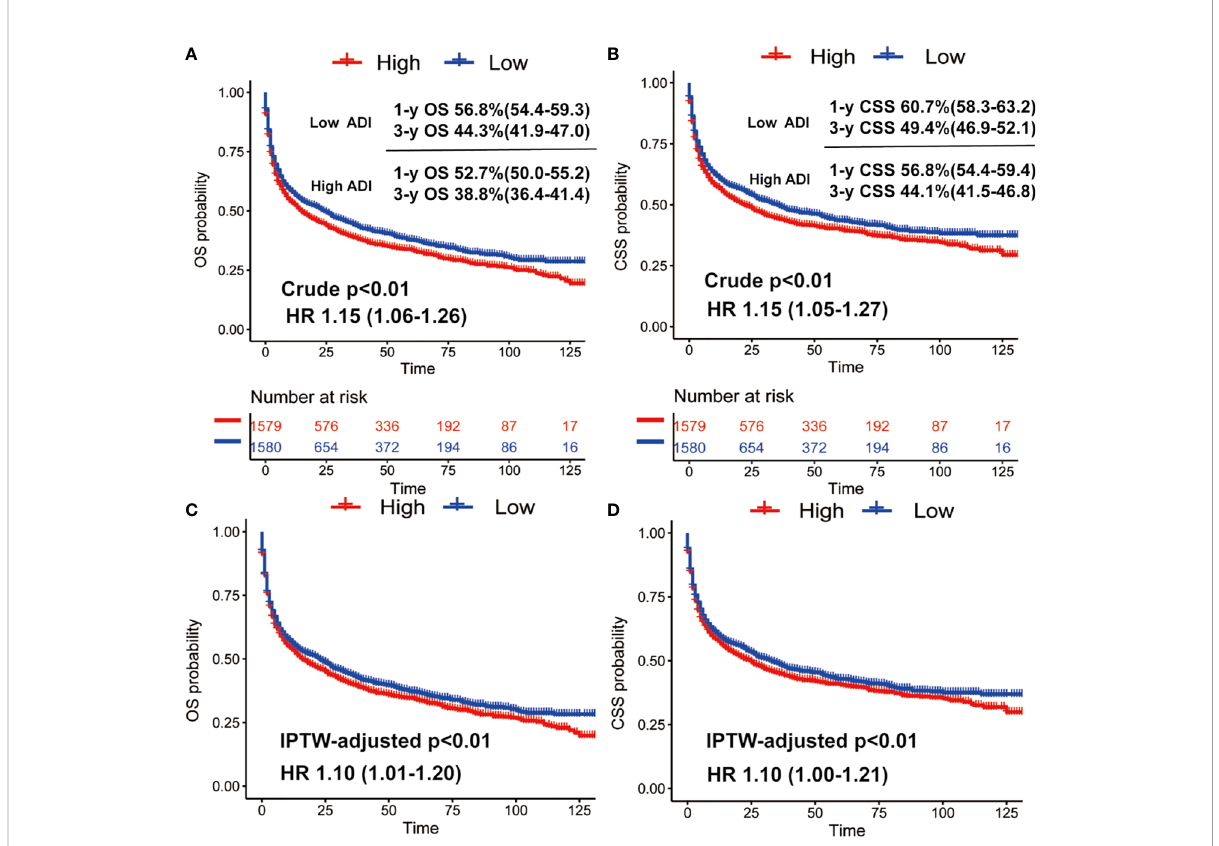
FIGURE 1 Crude Kaplan-Meier survival curves strati fi ed by ADI for overall survival (A) and cancer-speci fi c survival (B) ; IPW-adjusted Kaplan-Meier survival curves strati fi ed by ADI for overall survival (C) and cancer-speci fi c (D)